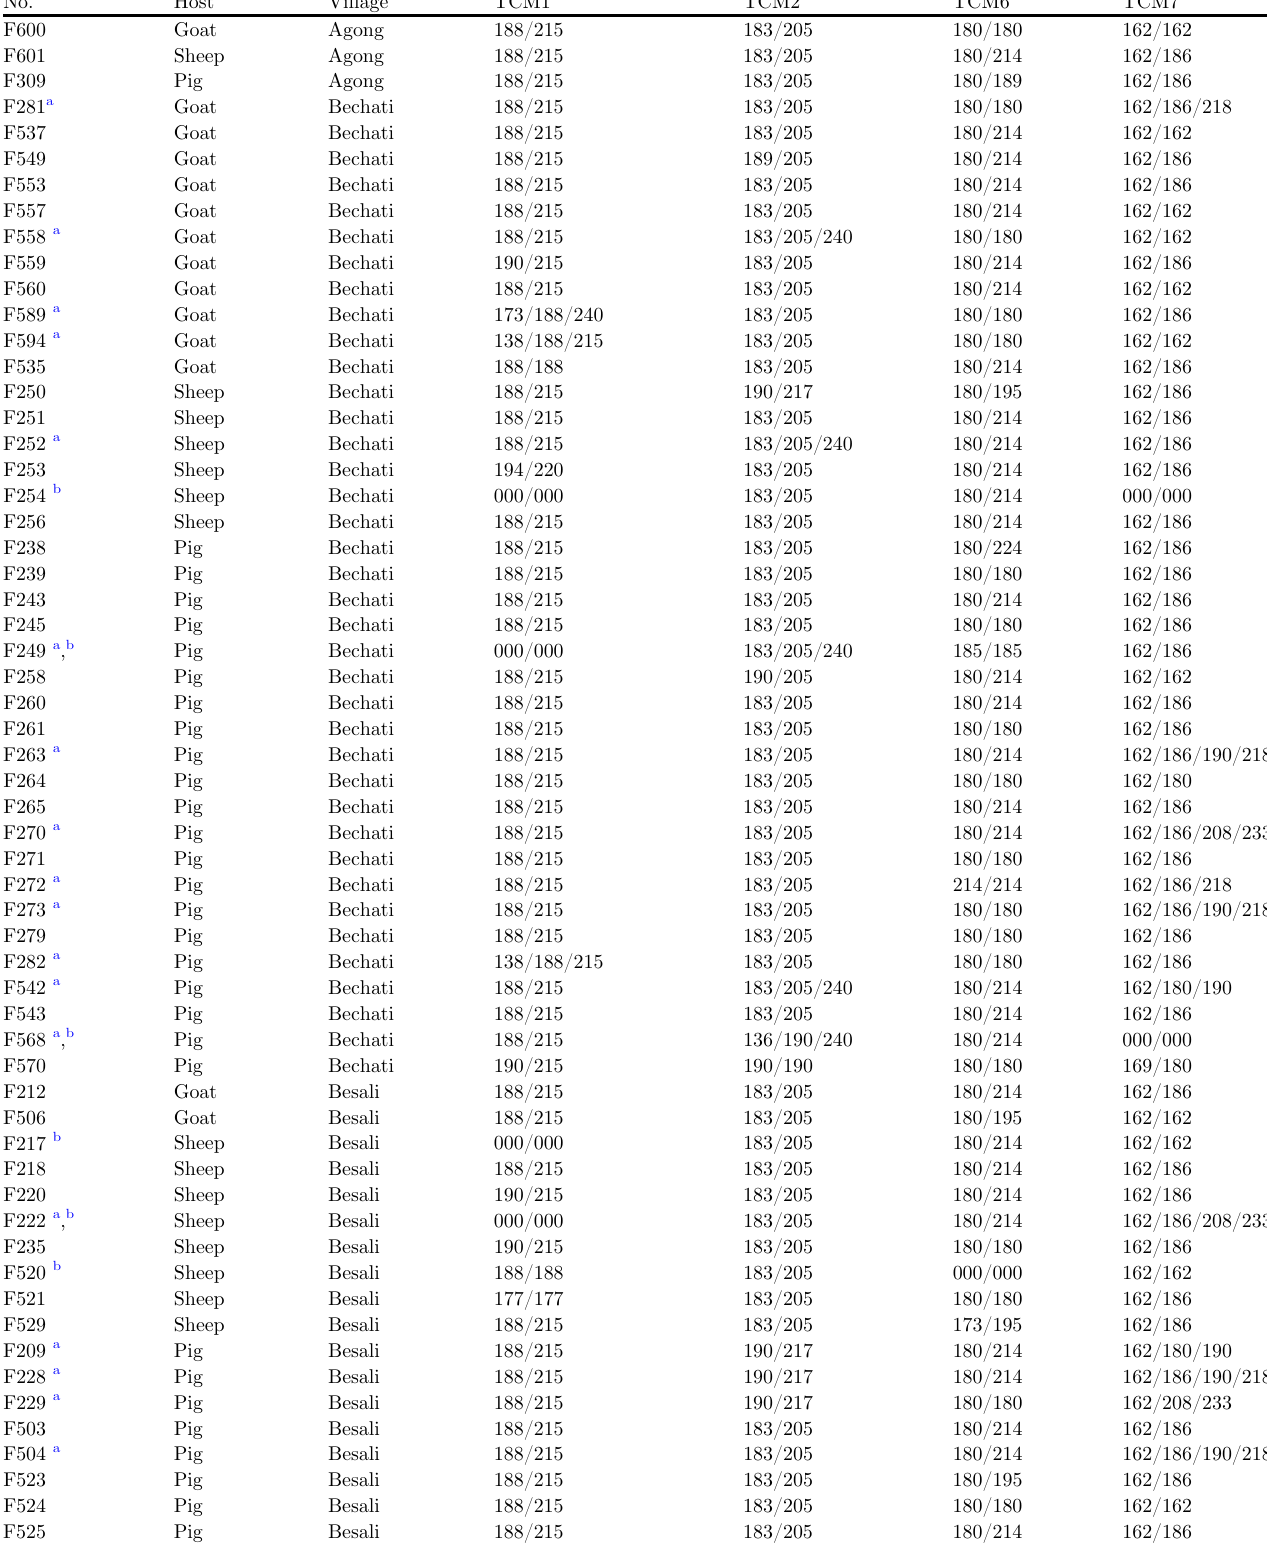
Table A1. Genetic characteristics of T. congolense “ forest type ” circulating in domestic animals and tsetse fl ies, size of alleles at each microsatellite